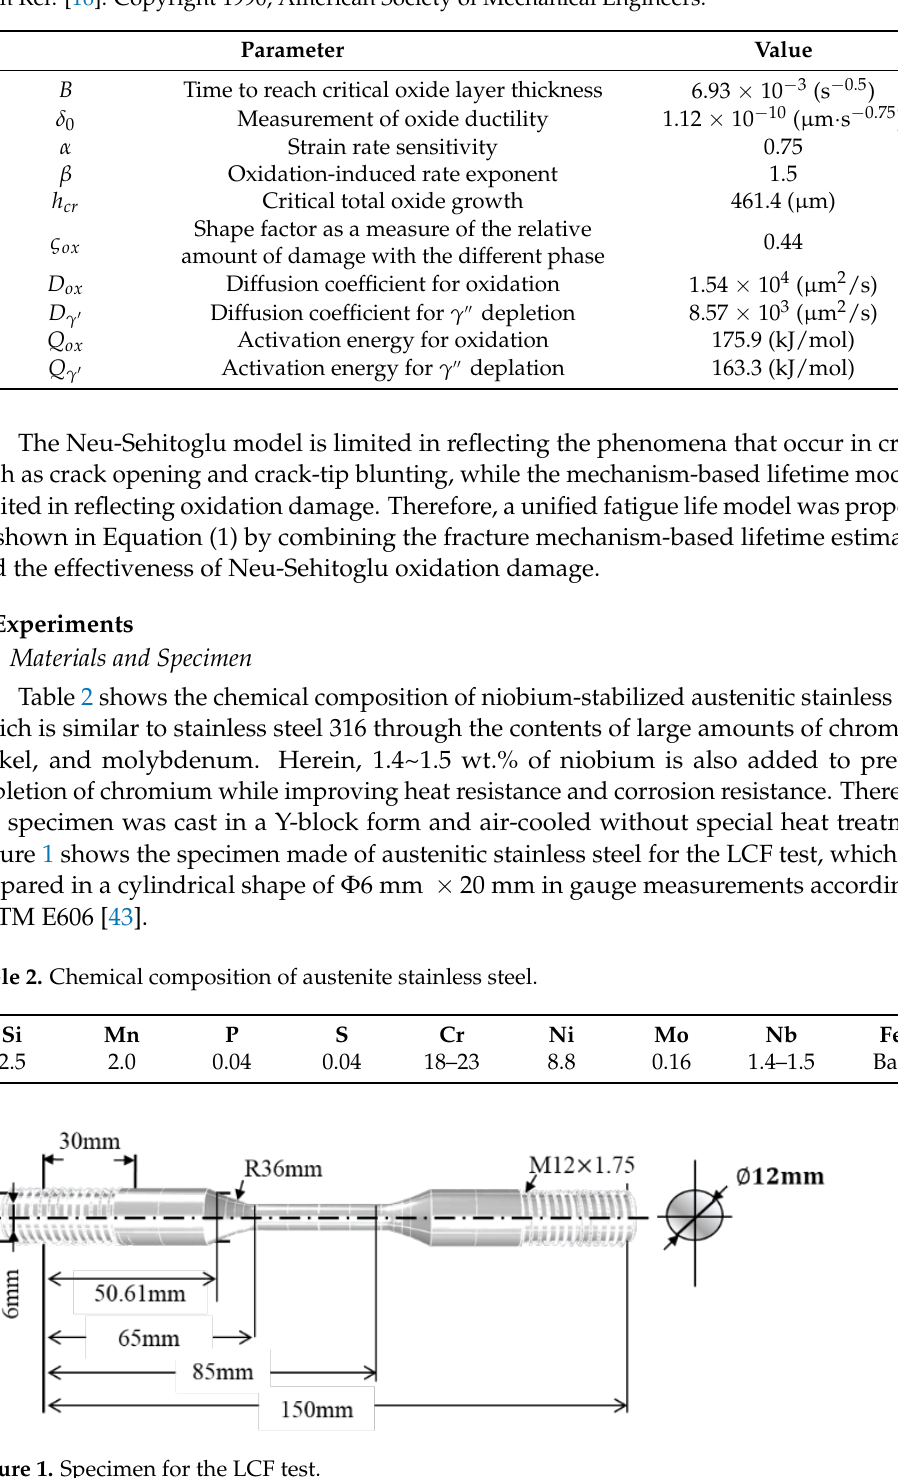
Table 1. Oxidation damage variables presented by Sehitoglu for Mar-M247, adapted with permis-